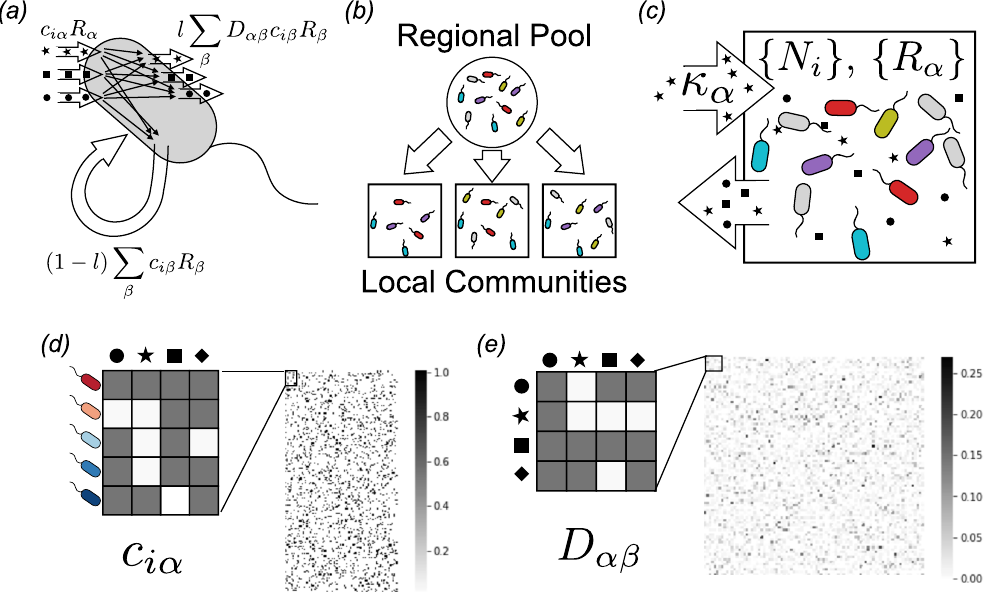
Figure 1. A minimal model for investigating microbial biodiversity. ( a ) The Microbial Consumer Resource Model extends the classic Consumer Resource Model of MacArthur and Levins 11 by incorporating the generic exchange of secondary metabolites observed in microbial communities, as described in the Methods. Each consumed resource type α (stars, squares, circles) with abundance R α is taken up by species i at a rate c i α R α , and transformed into other resource types through metabolic reactions inside each cell with normalized stoichiometry matrix D αβ . A fraction l of the resulting chemical flux returns to the environment, where it can be consumed by other microbes, while the rest is retained and used for growth. ( b ) Communities are initialized by randomly sampling subsets of species from a given regional pool, simulating the effect of stochastic colonization. The importance of dispersal limitation for community assembly can be tuned by adjusting the number of species in each the subset. ( c ) Each community is supplied with a constant influx of specified resource types, and all resources are diluted at a fixed rate. We assume that each community is well-mixed, so that its state is fully defined by the set of resource abundances R α and microbial population sizes N i . ( d ) Heat map of randomly sampled matrix of consumer preferences c i α with S = 200 species and M = 100 resource types. ( e ) Heat map of randomly sampled metabolic matrix D αβ , which encodes the allowed metabolic transformations and their relative rates, shown here with M = 100 resource